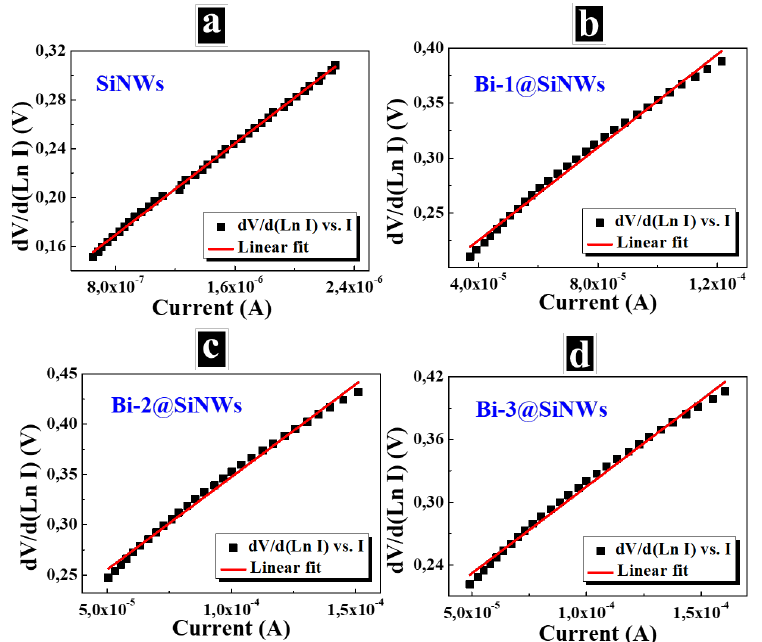
Figure 5. dV/d(LnI) vs. I plots of the prepared devices. ( a ) SiNWs-based device. ( b ) Bi-1@SiNWs- based device. ( c ) Bi-2@SiNWs-based device. ( d ) Bi-3@SiNWs-based